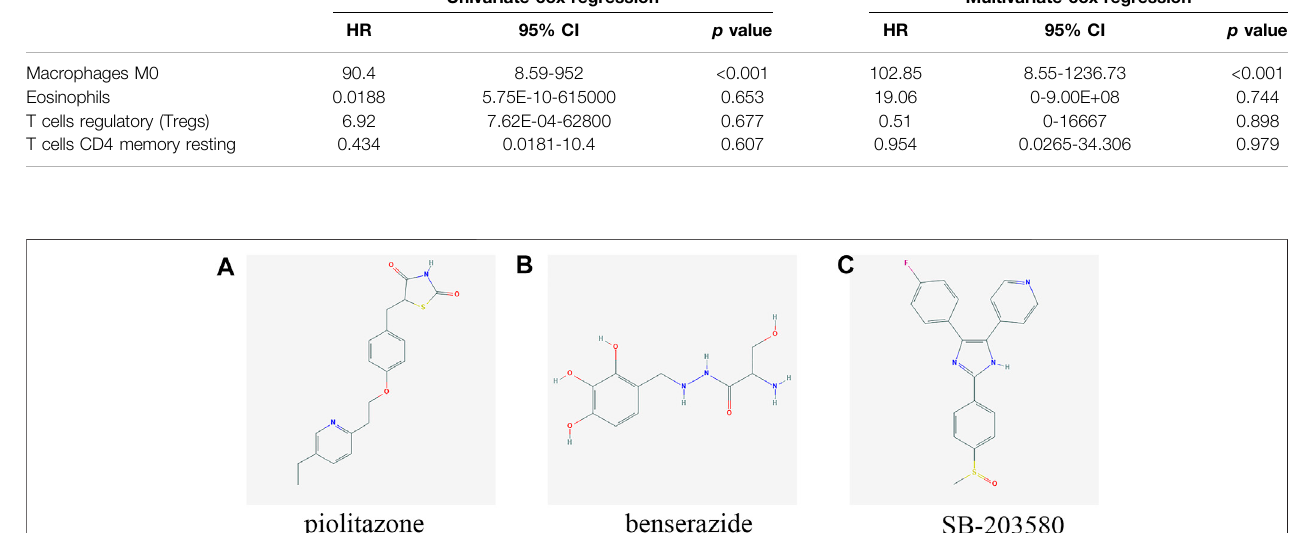
FIGURE 10 | Structures of the three most signi fi cant bioactive chemicals. (A) pioglitazone (B) benserazide (C) SB-203580.